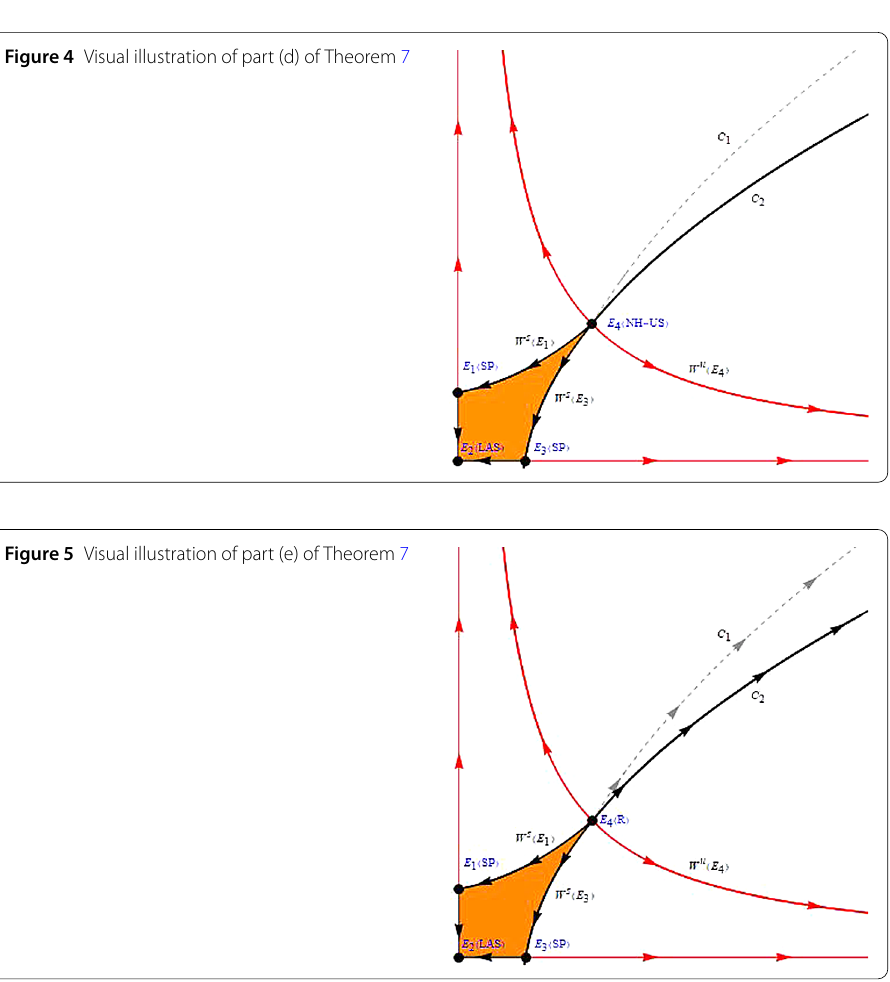
Figure 4 Visual illustration of part (d) of Theorem 7